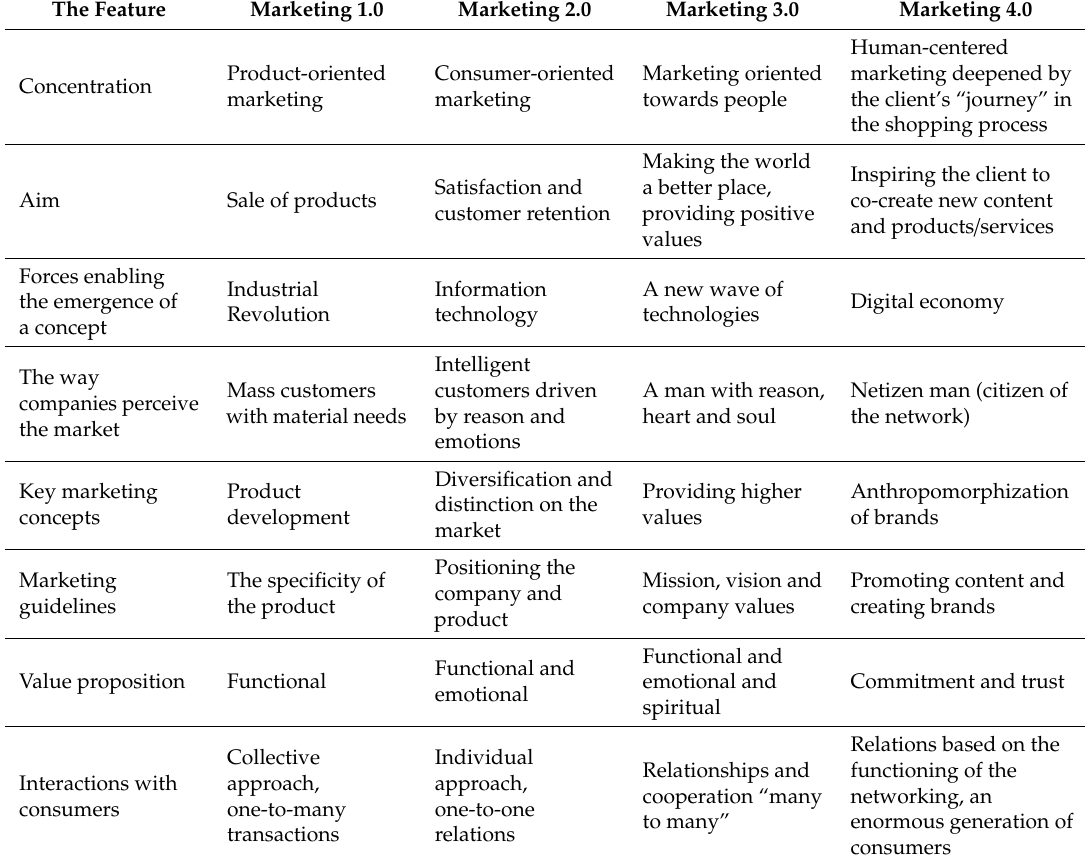
Table 1. Comparison of modern generations of Marketing 1.0, 2.0, 3.0 and